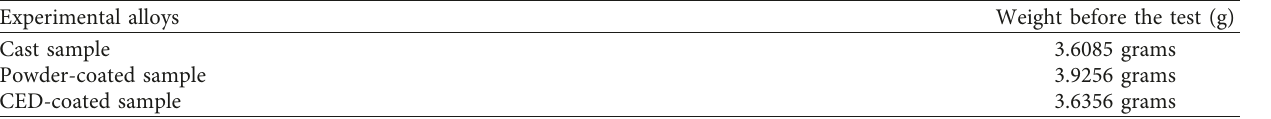
Figure 11: Salt spray test samples: (a) before the test, (b) 24h, and (c) 120h. Table 5: Weight of samples before salt spray test.